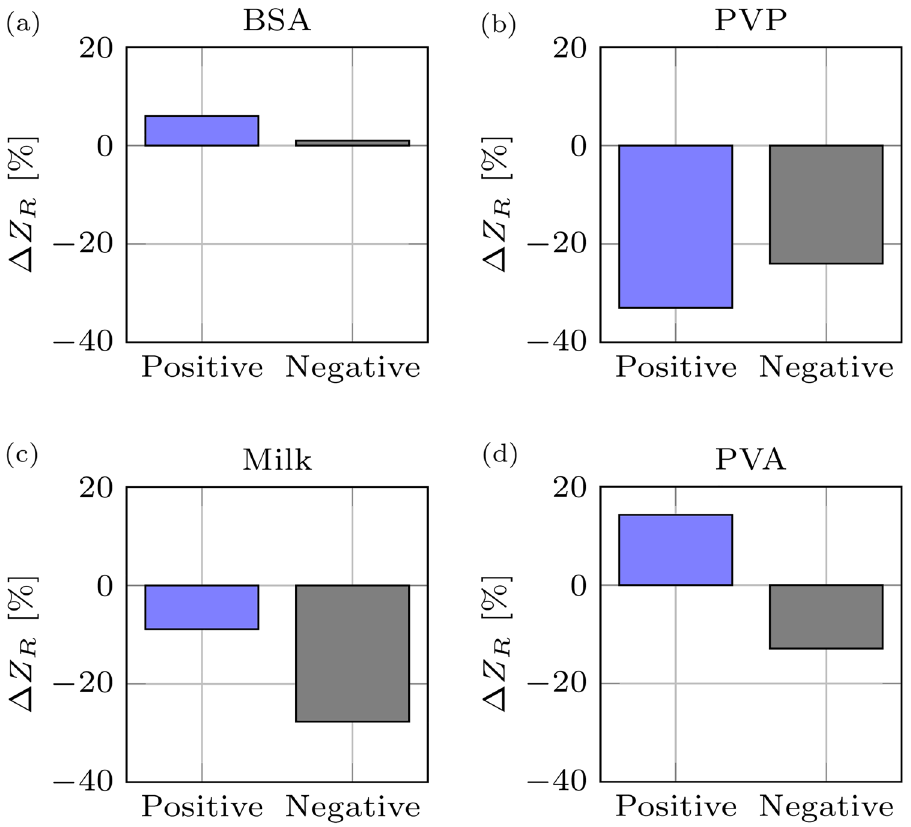
Figure 5. Optimization of impedance signal using different blocking agents. Individual positive and negative serum samples were mixed with ( a ) 1% bovine serum albumin (BSA); ( b ) 3% polyvinyl pyrrolidone